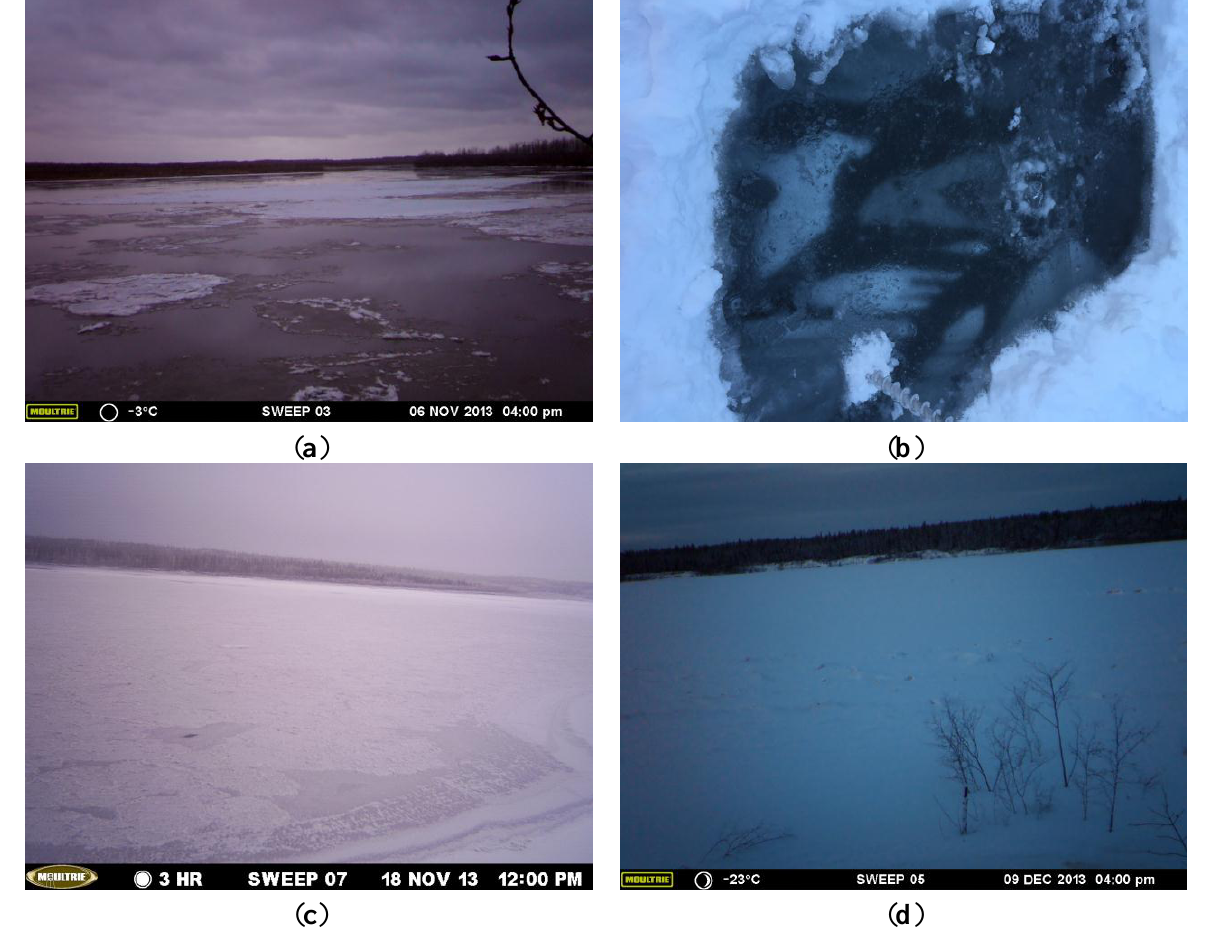
Figure 4. The formation of different ice types along the Slave River from Fort Smith to Great Slave Lake ( a ) including frazil pans or ice floes; ( b ) thermal ice; ( c ) juxtaposed ice, channel ( a ) and Bell Rock Landing in Fort Smith, upstream of the delta channel ( c and d